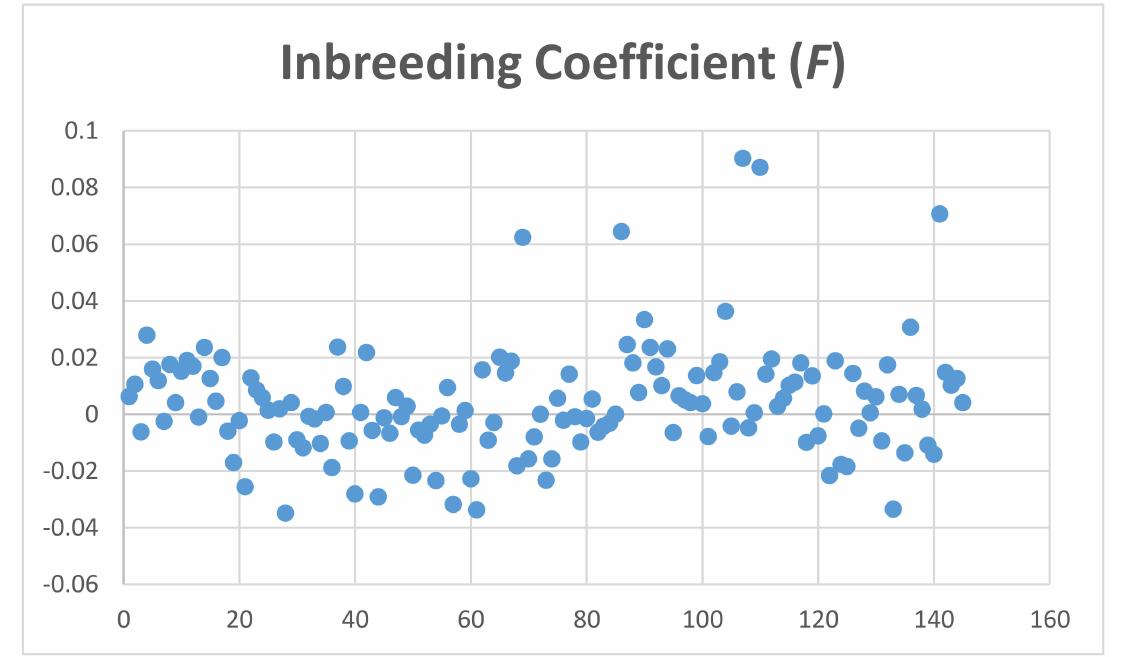
Figure 4. Inbreeding coefficient (F) of alpacas genotyped by microarray.